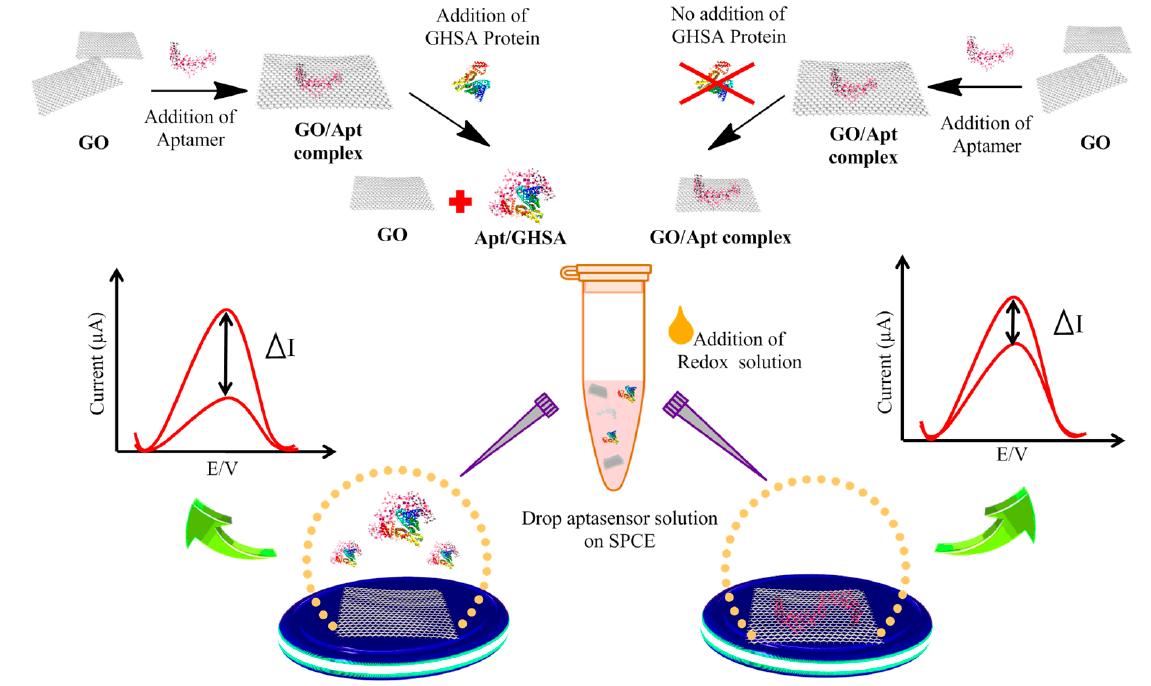
Figure 1. Schematic illustration of the immobilization ‐ free electrochemical sensor coupled with the graphene oxide (GO) ‐ based aptasensor for glycated human serum albumin (GHSA) detection. In the presence of GHSA, the aptamer detaches from the GO surface and specifically binds to GHSA, leading to adsorption of free GO on the electrode surface. In the absence of GHSA, the aptamer is still attached on the GO surface, leading to adsorption of the GO ‐ aptamer complex on the electrode surface. After square wave voltammetry (SWV) determination, the current change ( Δ I) is calculated and plotted against the GHSA concentration.